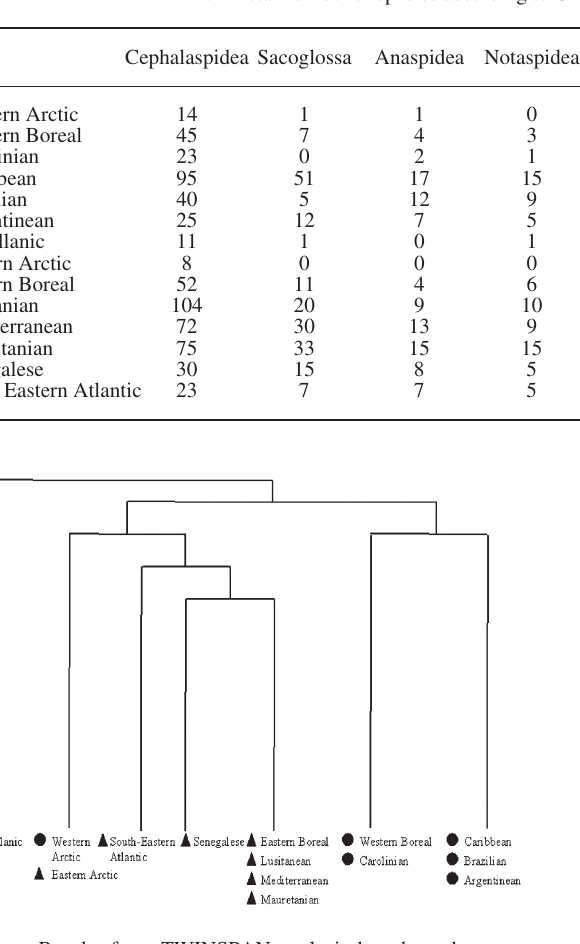
Fig . 1. – Results from TWINSPAN analysis based on the pres- ence-absence of species in the biogeographic areas. Circles, western regions; triangles, eastern regions. Fig . 2. – Multidimensional scaling (MDS) ordination of the simi- larity of the biogeographic areas based on the presence-absence of